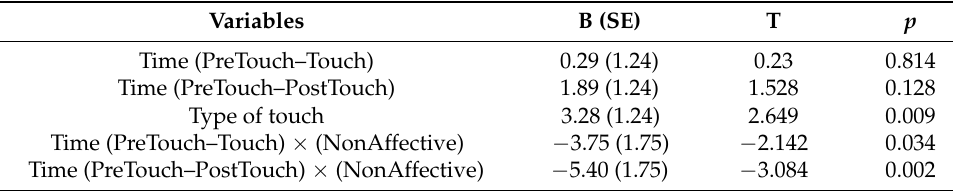
Table 6. Summary of the most plausible-fitting model predicting